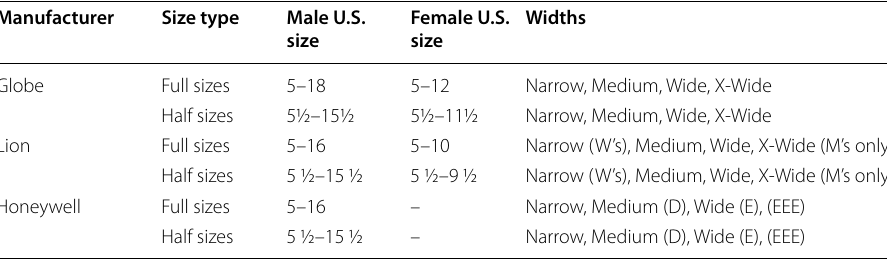
From Globe (2022b), Lion (2021), Honeywell (2019)